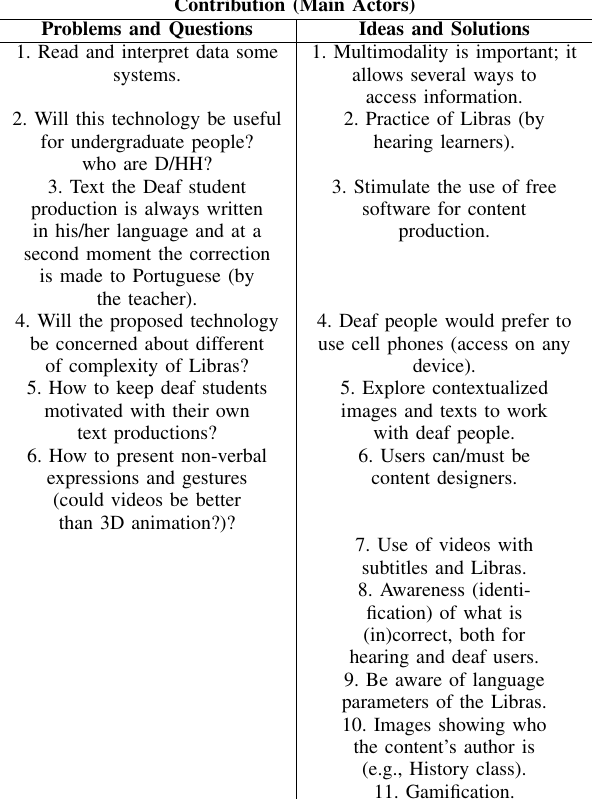
TABLE III E VALUATION F RAME RESULTS FOR THE C ONTRIBUTION